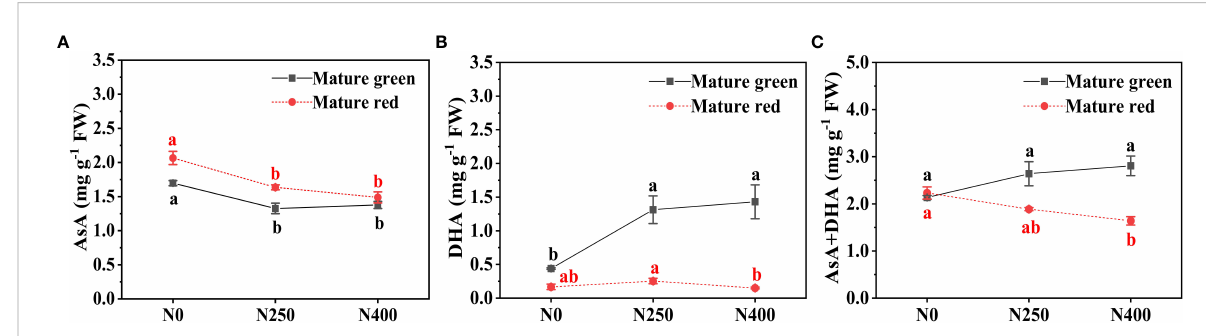
FIGURE 1 Content of AsA (A) , DHA (B) and total vitamin C (AsA+DHA) (C) in the pericarp of pepper fruits at mature green and red stage produced under different N levels. Values (means ± SE, n = 4) followed by different letters indicate signi fi cant difference between N levels at the same growth stage at P < 0.05 according to the Duncan ’ s multiple range